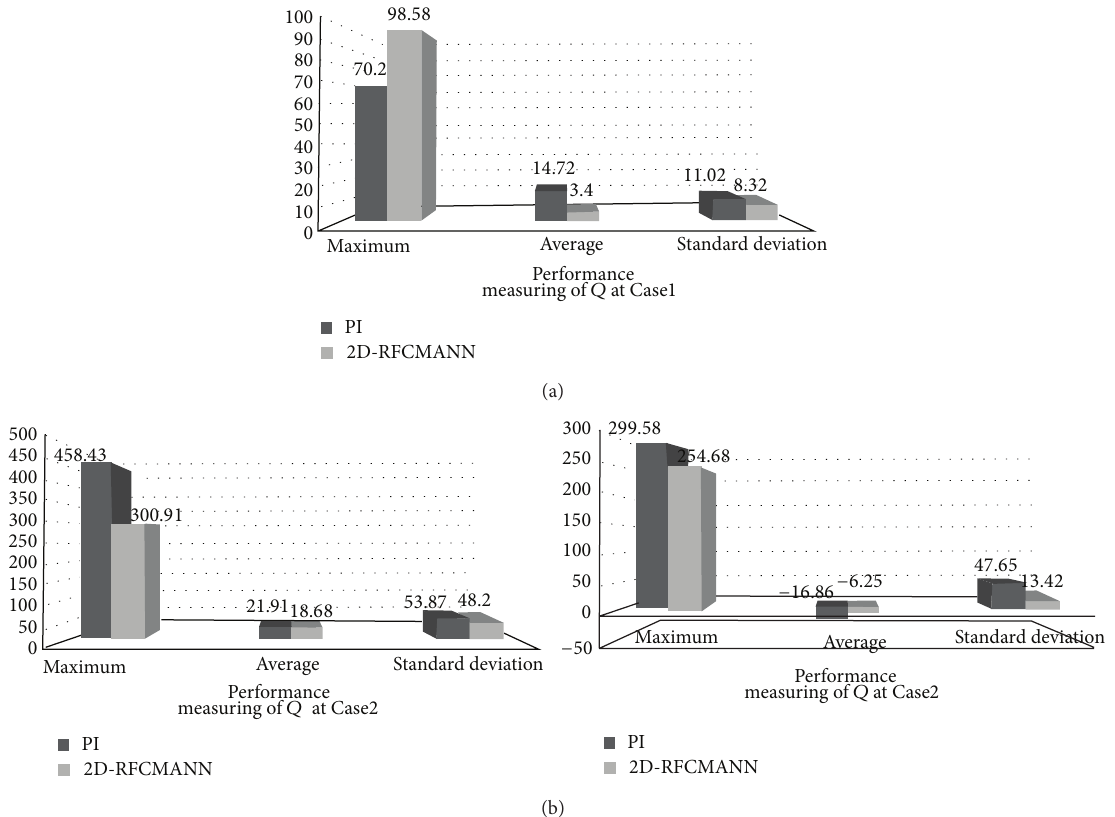
Figure 8: Performance measuring. (a) Performance measuring at Case 1. (b) Performance measuring at Case 2.